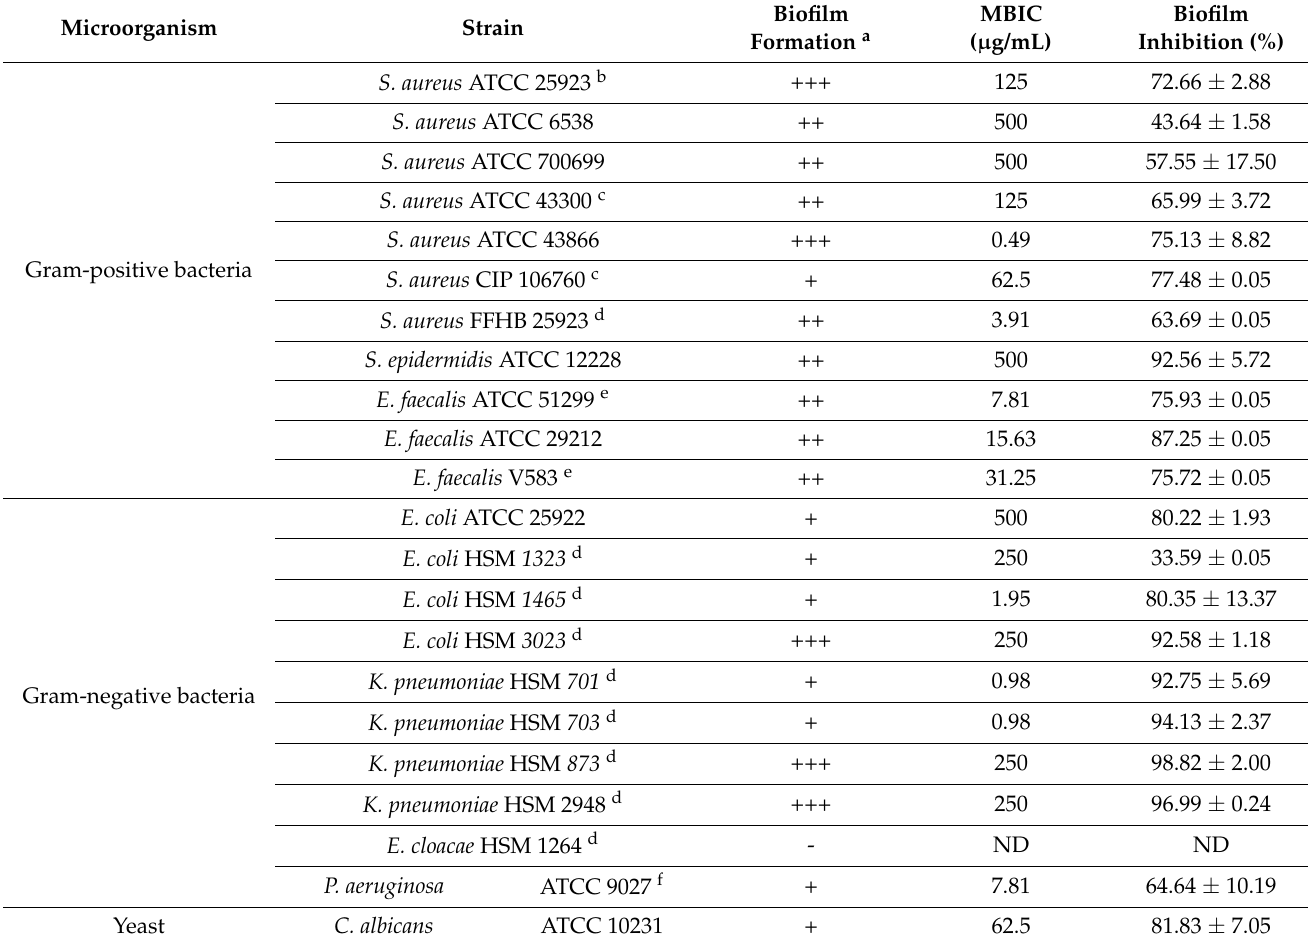
Table 3. Minimum biofilm inhibitory concentration (MBIC) values ( µ g/mL) and percentage of biofilm inhibition for DHA against a collection of Gram-positive and Gram-negative bacteria, and yeast. Results showed as mean ± SD, p < 0.05. Microorganism